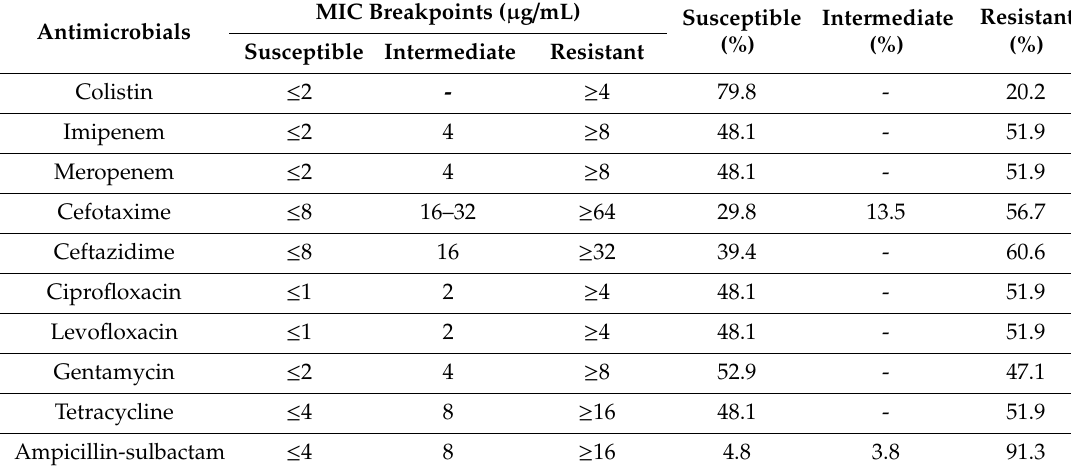
Table 2. Antimicrobials susceptibility profiles the Acinetobacter baumannii isolates (n = 104). S, I, and R represent susceptible, intermediate, and resistant, respectively.